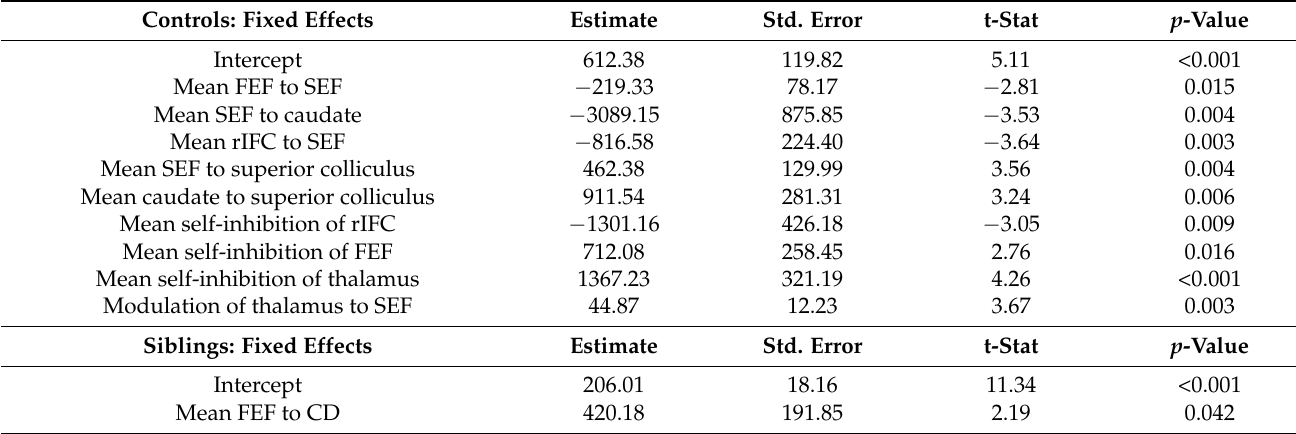
Table 5. Final regression model from the backward elimination procedure predicting TSRTs within each group using standardized DCM parameters showing credible group